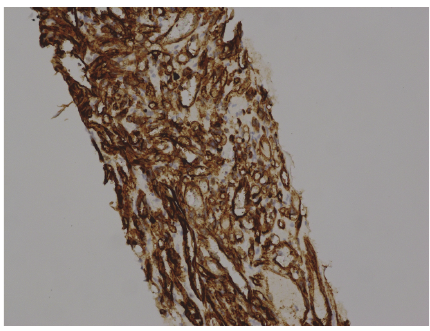
Figure 2: Primary splenic angiosarcoma. Immunohistochemical CD34 staining. 20-fold magnification.